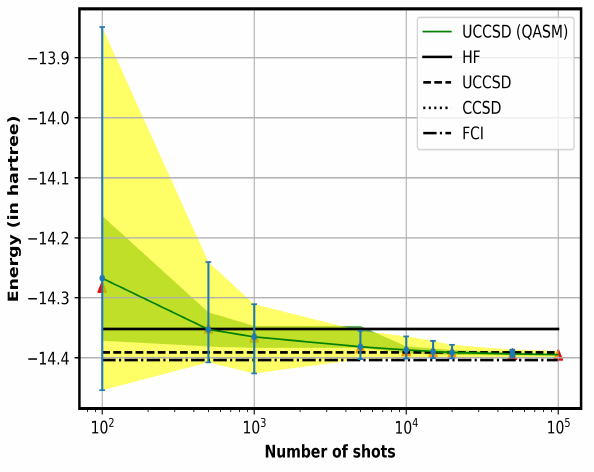
Figure 2. Analysis of the unitary coupled cluster energy from the QASM backend (UCCSD(QASM)) versus the number of shots, for Be in STO-3G basis and with Jordan–Wigner mapping. The results obtained using the QASM backend are also compared with the values obtained using the full configuration interaction (FCI), coupled cluster in singles and doubles approximation (CCSD), and the unitary coupled cluster in the singles and doubles approximation (UCCSD) methods on a classical computer. Each data point (circle) represents the mean of 160 runs for a given number of shots, and is accompanied by two error bars, with the band in yellow quoting the range (maximum–minimum), while the green band denotes the standard deviation. The data points marked with a triangle refer to the bootstrapped mean. The CCSD and the FCI lines overlap exactly, owing to their agreement to the fifth decimal place, as Table 1 shows.